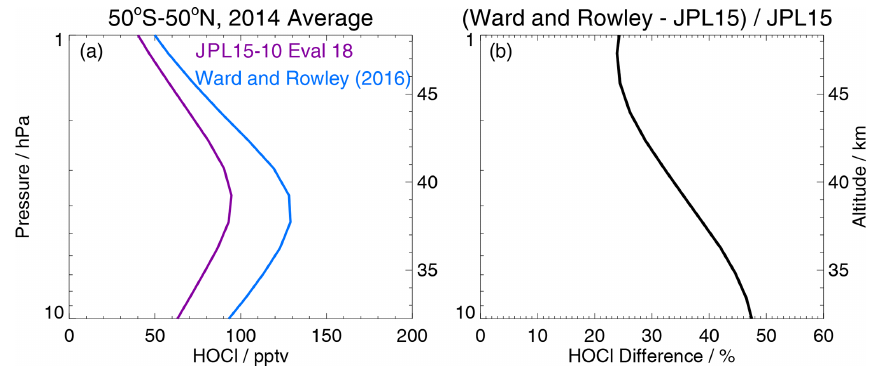
Figure 7. (a) Sensitivity of average (for 2014, 50 ◦ S to 50 ◦ N) model upper stratospheric HOCl profile (pptv) to the choice of rate constant for the HOCl formation reaction between HO 2 and ClO. The JPL 15-10 Evaluation 18 rate constant choice gives the purple average profile, whereas the larger rate constant derived by Ward and Rowley (2016) leads to the blue average profile. (b) The percent difference (increase) between the two curves in panel (a) (blue minus